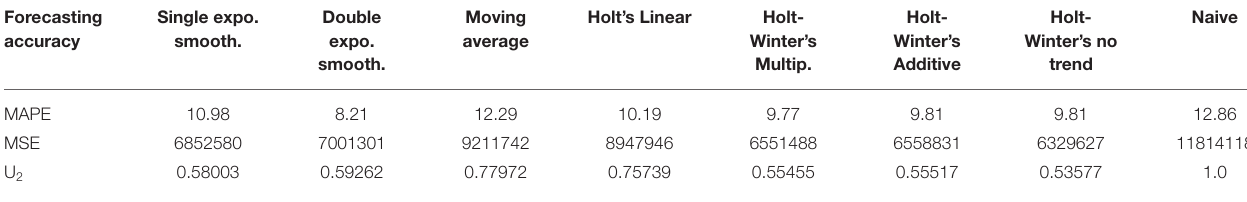
TABLE 6 | The results of forecasting (third approach and product without shortage). Forecasting Single expo. accuracy